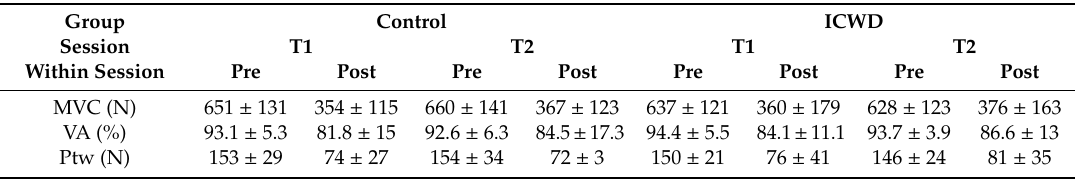
Table 2. Neuromuscular results. Mean ± SD of maximal voluntary contraction (MVC) in N), voluntary activation (VA in %) and potentiated twitch at rest (Ptw in N) of both groups (Control vs. ICWD) at T1 and T2 sessions and pre- and post-knee extension task.